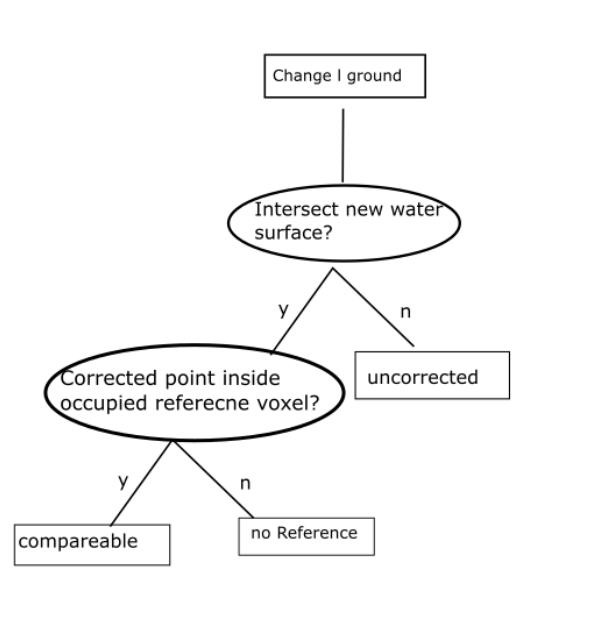
Figure 2. Scheme of the decision tree for assigning change labels. Input are the ground points and new points in the river area.